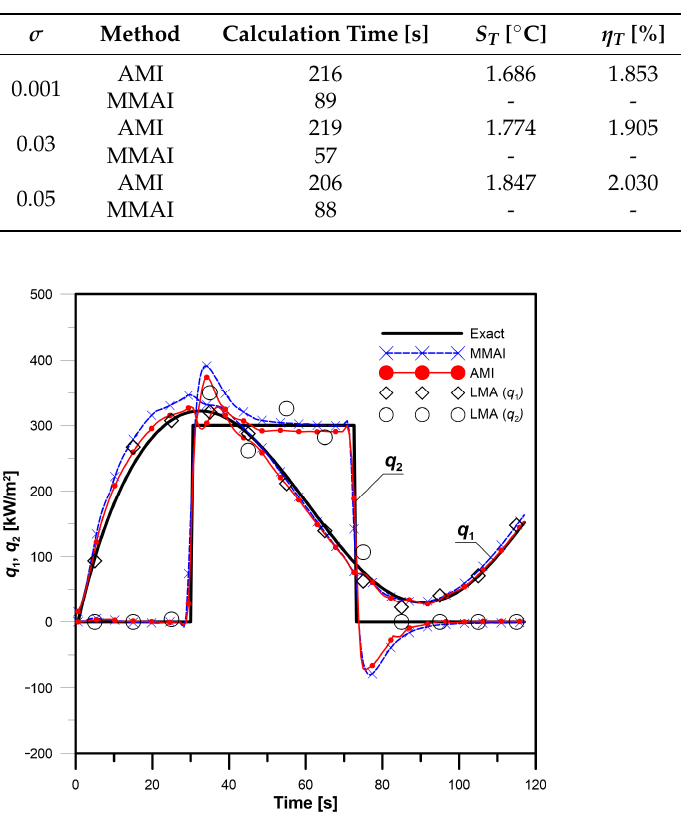
Figure 7. Comparison between exact heat fluxes and those calculated by the MMAI, AMI, and LMA methods.